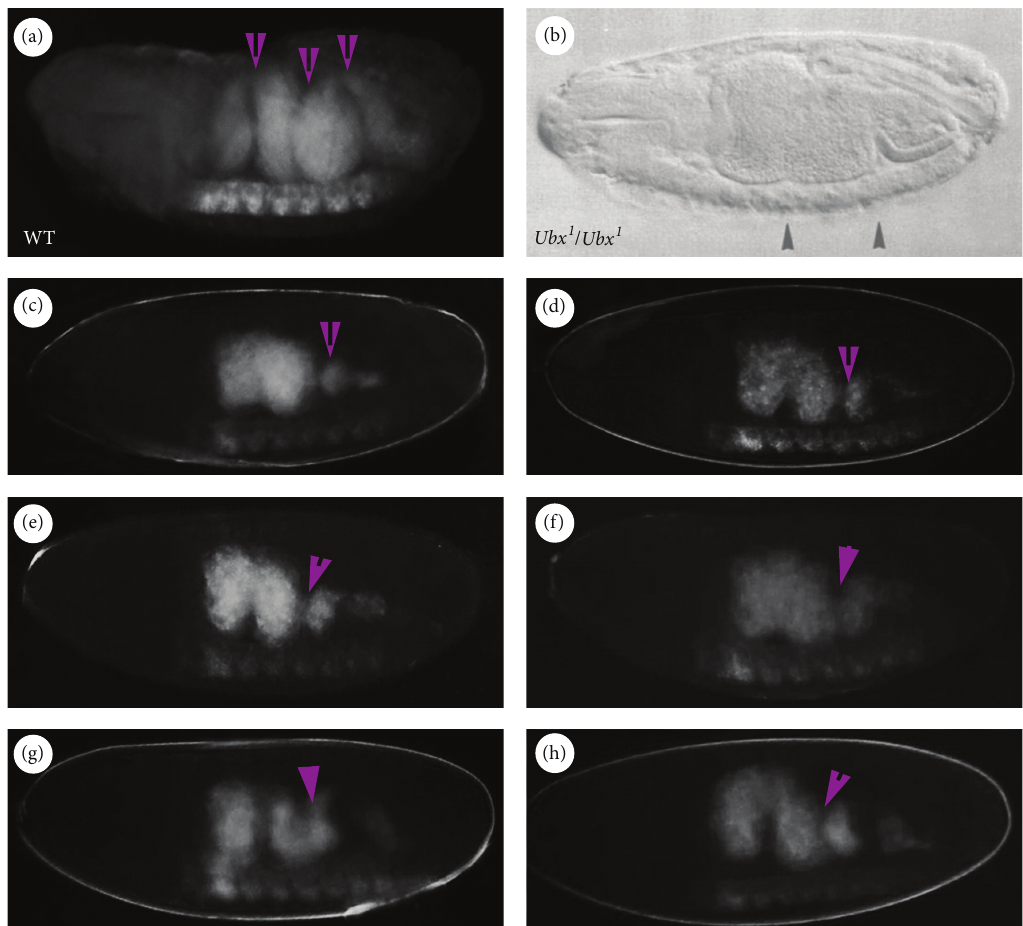
Figure 8: Midgut analysis. (a) Wild type midgut with all 3 constrictions indicated by purple arrowheads. Left arrowhead: 1st constriction; middle arrowhead: 2nd constriction; right arrowhead: 3rd constriction. (b) The 2nd constriction is missing in homozygous Ubx 1 mutant embryos [16]. (c)–(h) show several examples of Ubx-YFP embryos with complete midguts. The 2nd constriction of the midgut is indicated by purple arrowhead. Panel B is reproduced from [16] with